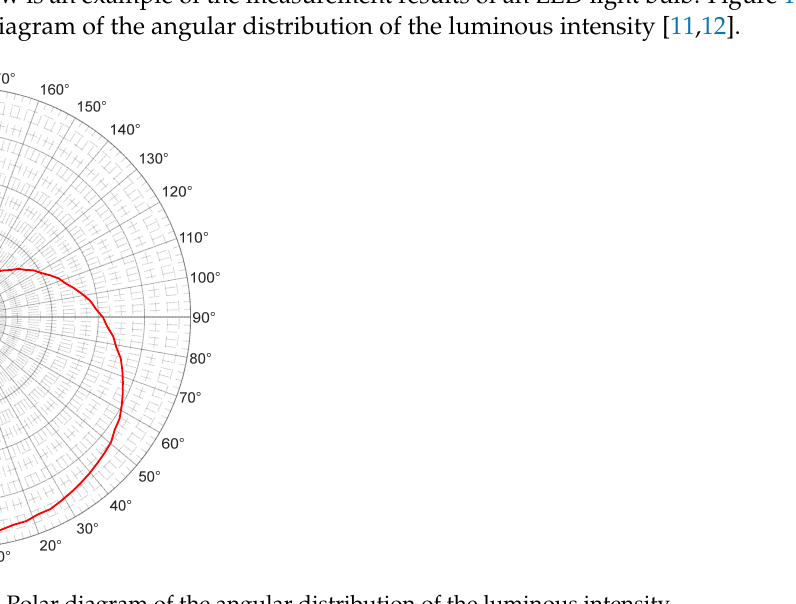
Figure 16. Electric circuit diagram for switching the light bulb ON/OFF (circled area).